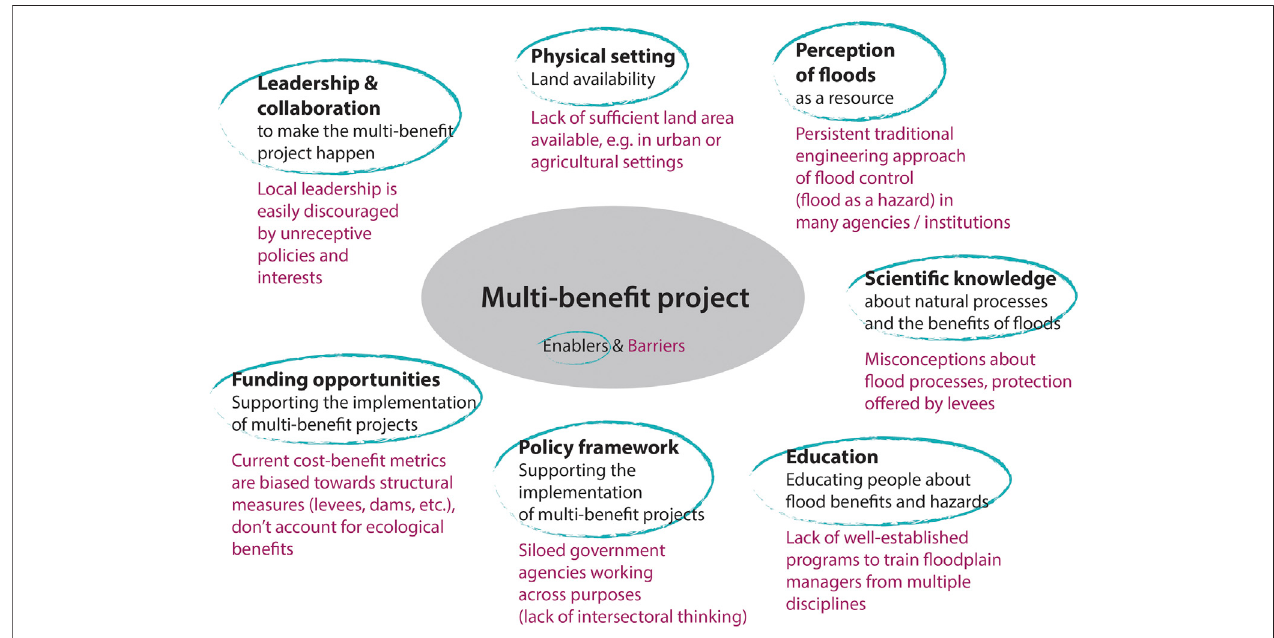
FIGURE 11 | Enablers and barriers for the realization of multi-bene fi t projects as learned from the four case studies.